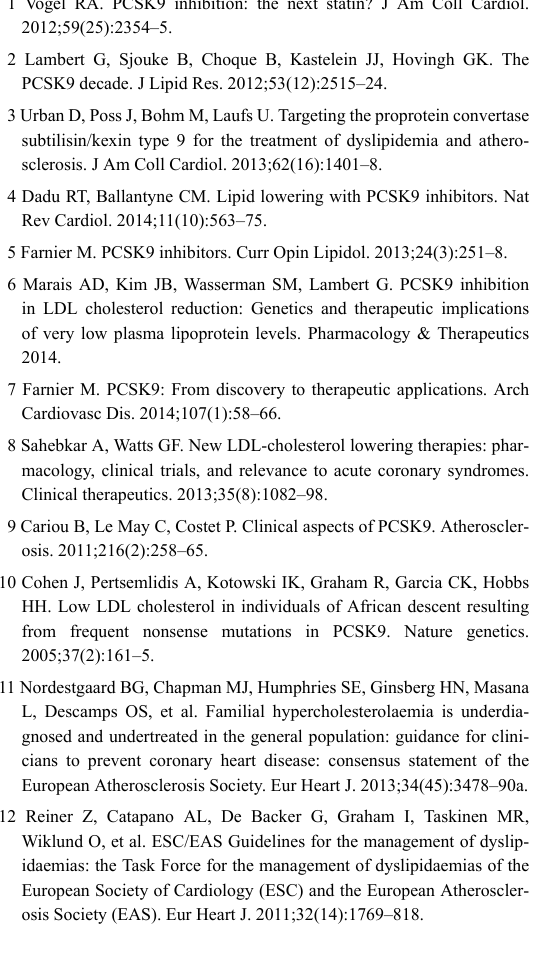
Table 3: Phase III clinical trials of bococizumab (PF-4950615, RN-316), developed by Pfizer. Study